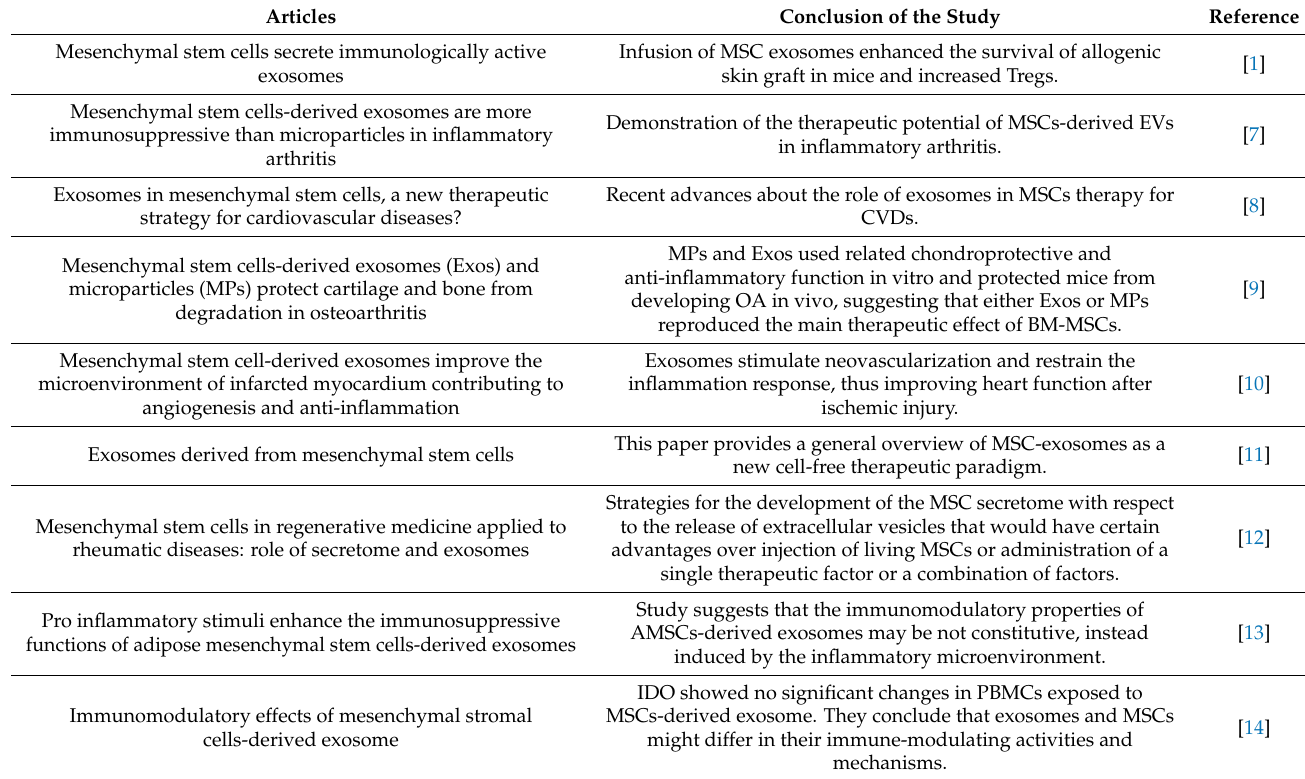
Table 3. Studies showing the anti-inflammatory role of mesenchymal stem cells-derived exosomes.